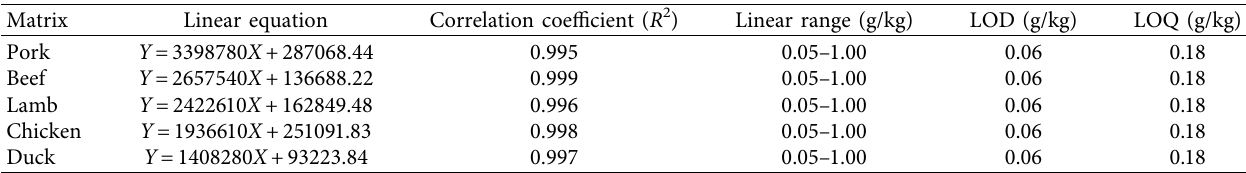
Table 1: Linear equation, correlation coefficient, detection limit, and quantification limit of carrageenan as determined by UHPLC-MS/MS ( n � 6).